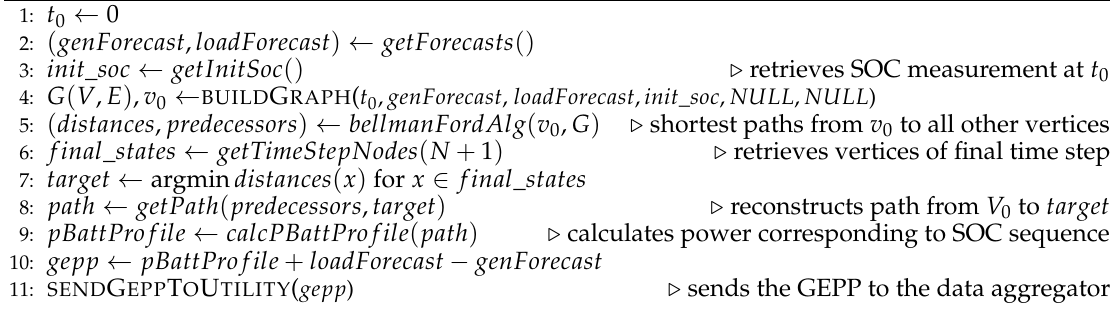
Algorithm 2 Pseudo-code of the Planning